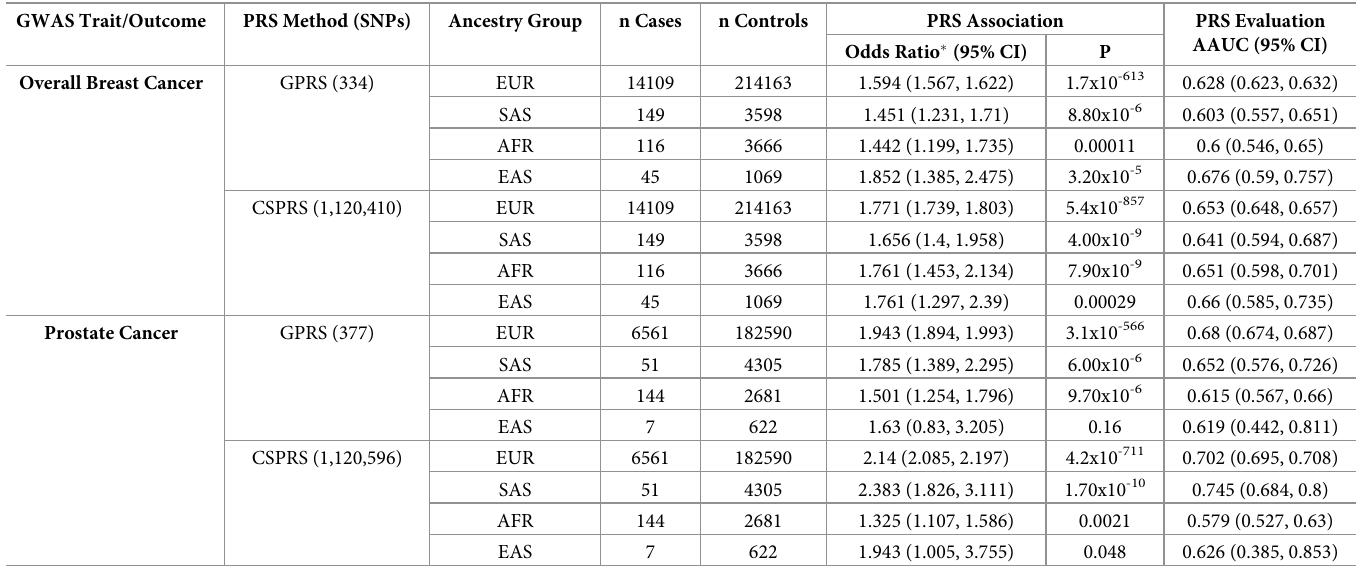
Table 1. Association and evaluation of cancer PRS across ancestry